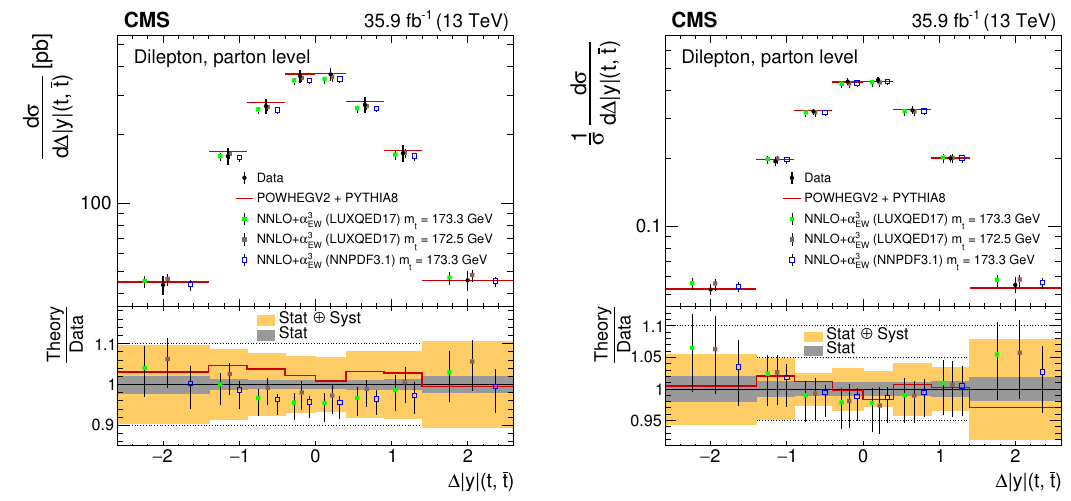
Figure 21 . The di(cid:11)erential tt production cross sections at the parton level in the full phase space as a function of (cid:1) j y j (t ; t) are shown for the data ((cid:12)lled circles), the theoretical predictions with beyond-NLO precision (other points) and the prediction from powheg + pythia (solid line). The vertical lines on the (cid:12)lled circles and other points indicate the total uncertainty in the data and theoretical predictions, respectively. The left and right plots correspond to absolute and normalised measurements, respectively. The lower panel in each plot shows the ratios of the theoretical pre- dictions to the data. The dark and light bands show the relative statistical and total uncertainties in the data, respectively.